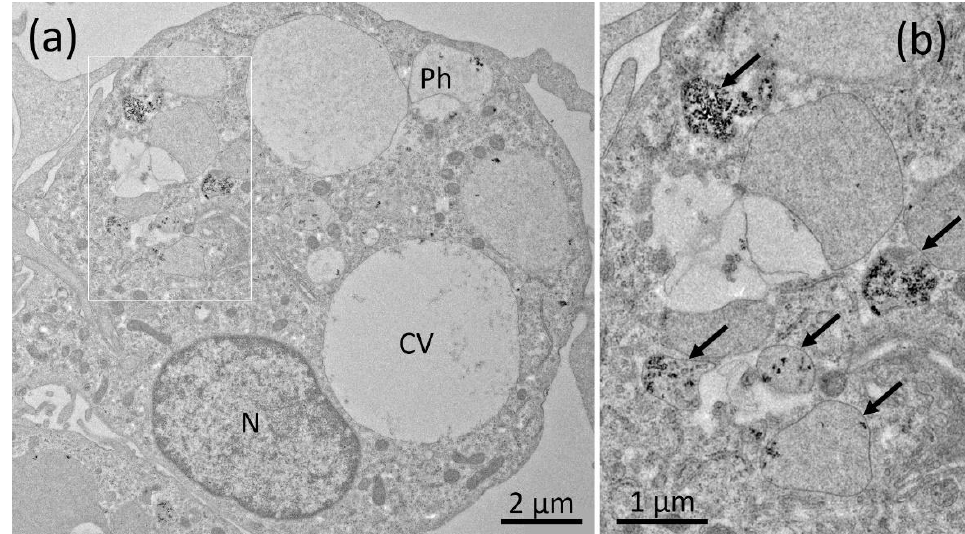
Figure 4. Electron microscopy of NR8383 cells laden with AEROSIL ® 380 F (11.25 µg/mL) in the presence of FCS for 16 h. ( a ) Aspect from a cell with typical phagosomes (Ph) mainly filled with fine granular material, particle laden lysosomes and a clear vacuole (CV). ( b ) Boxed area from ( a ) showing several particle-laden lysosomes (arrows).